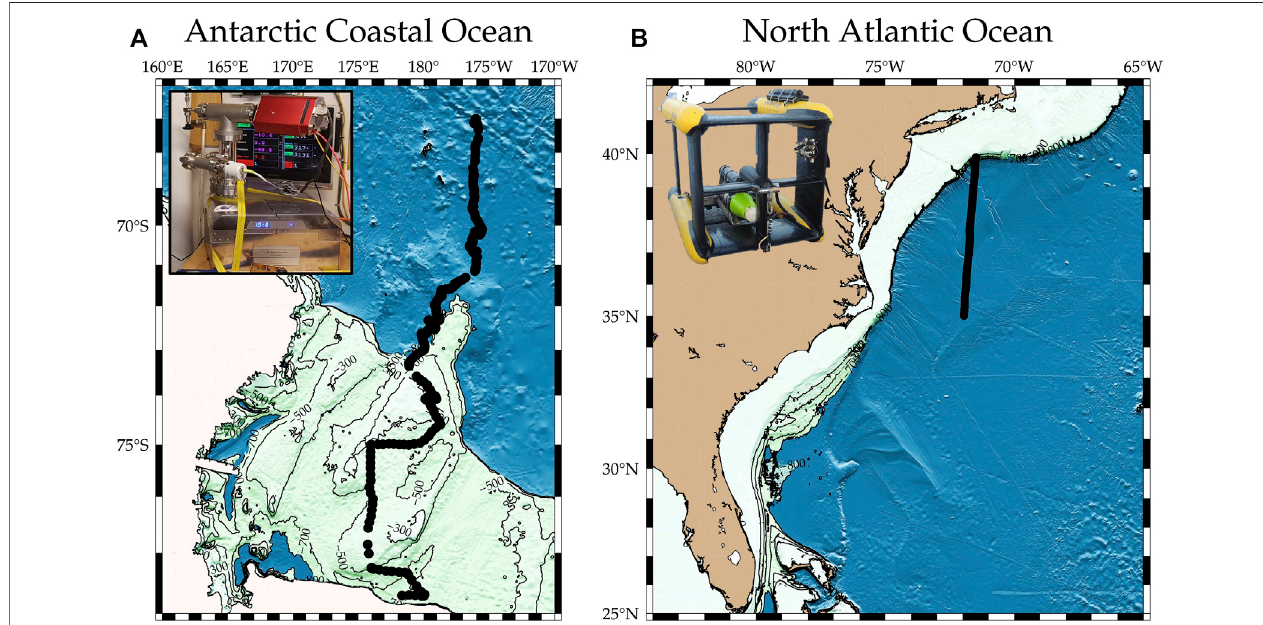
FIGURE 2 | Maps showing the ocean regions where QMS data were collected as part of oceanographic surveys. Panel (A) is a region in the Ross Sea, along the coast of Antarctica in the Atlantic sector; panel (B) shows a region of the North Atlantic, including the Gulf Stream and Labrador water. The measurements collected at these locations are the subjects of the additive model and neural network bias correction algorithms that we compare in this